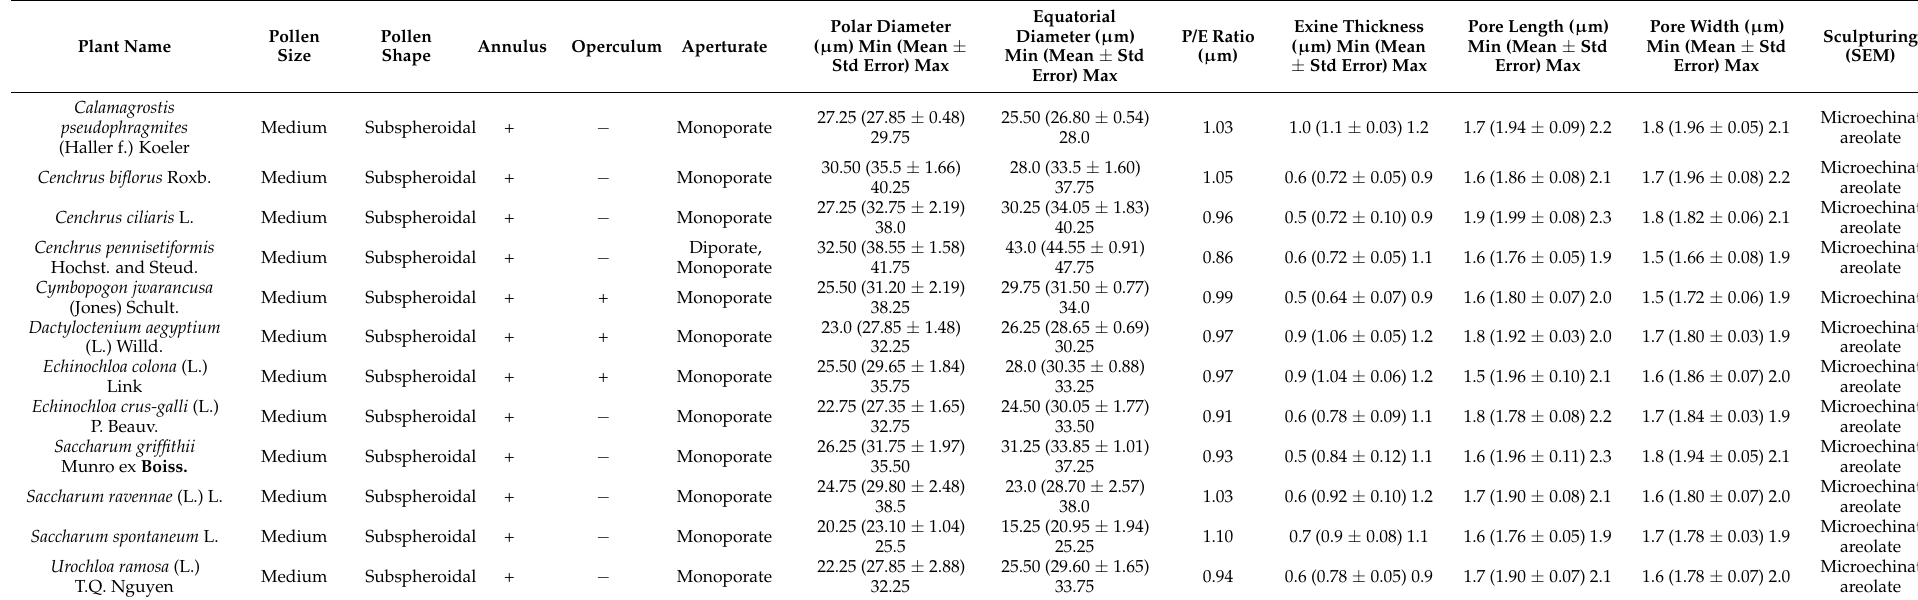
Table 1. Qualitative and quantitative pollen characteristics of salt-tolerant grasses from Northern Punjab,